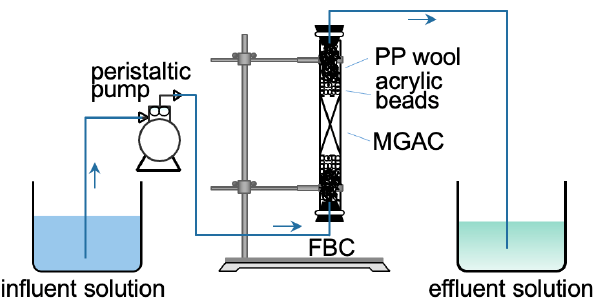
Figure 1. The schematic representation of FBC.